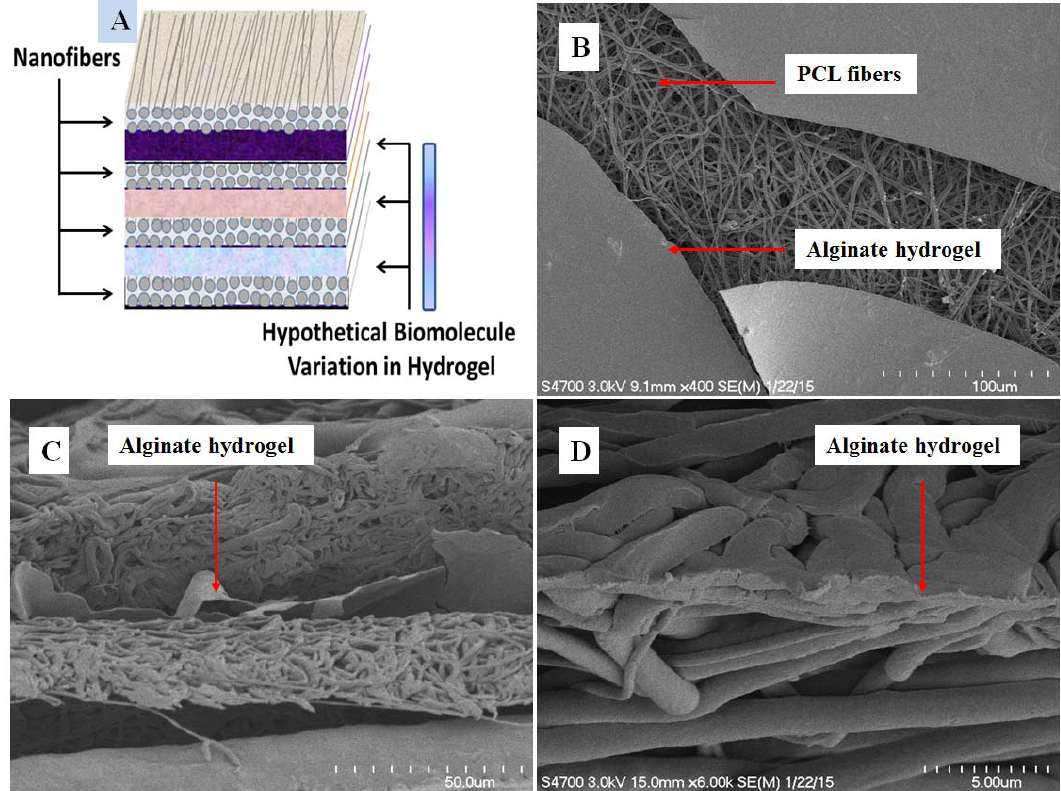
Figure 1. Topographical and texture characterization: ( A ) Diagram of a multilayer nanofiber-hydrogel mesh, showing the variation of the hypothetical bioactive molecules in the layers; ( B ) Top view SEM image showing the top two layers of a nanofiber-hydrogel mesh. The top layer alginate hydrogel was cracked to show the PCL nanofiber layer beneath; ( C ) Cross section SEM image of a multilayer nanofiber-hydrogel mesh, which was snapped in liquid nitrogen; ( D ) Cross section SEM image of the multilayer nanofiber-hydrogel mesh, which was cut in liquid